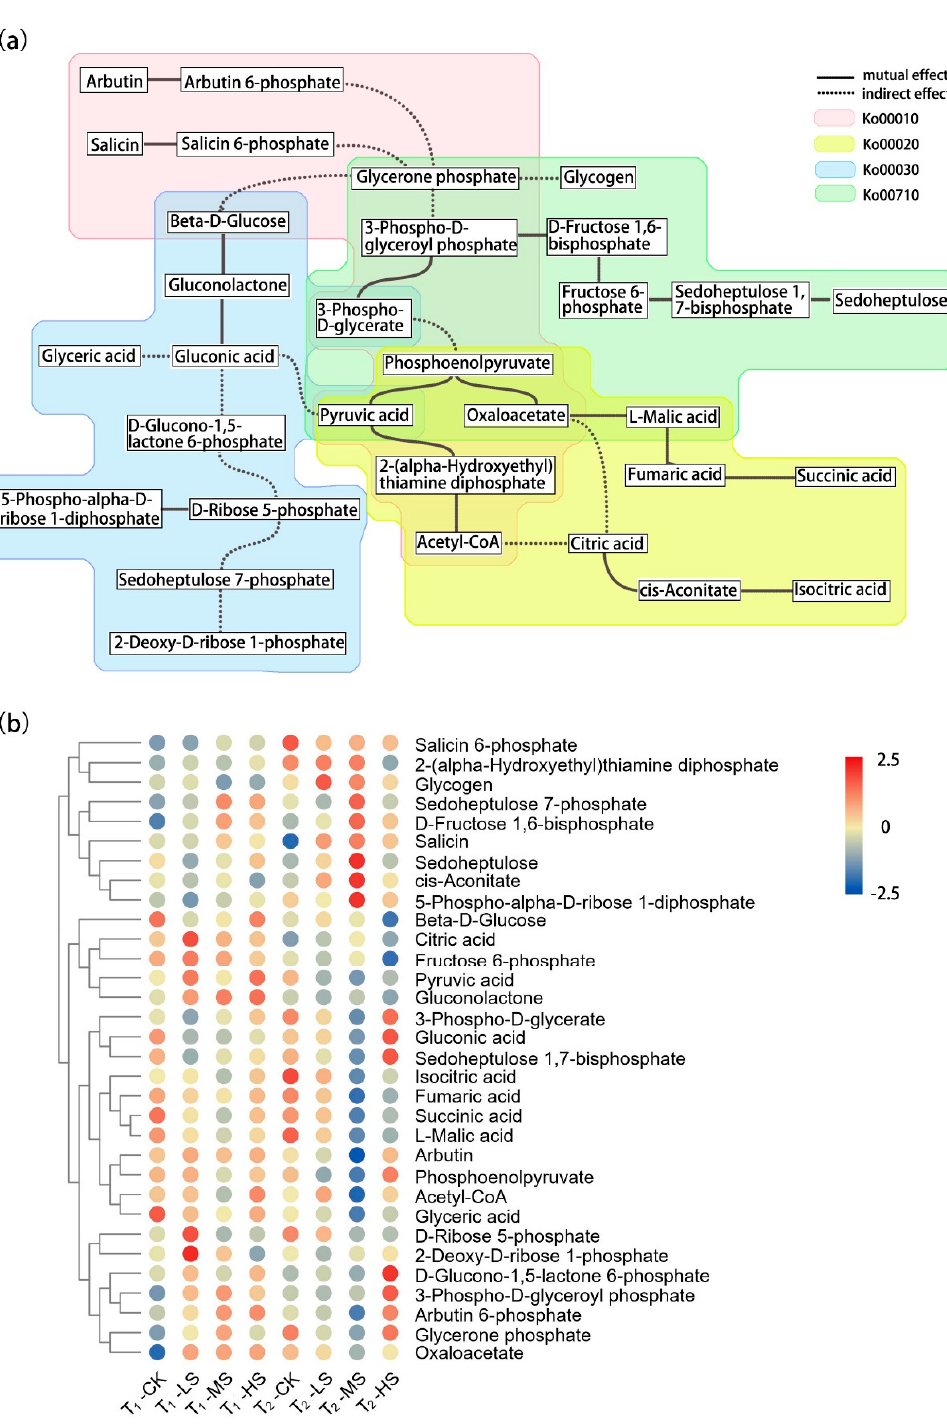
Figure 2. Changes in metabolite levels of C. paliurus leaves under different salt treatments and two sampling times. ( a ) Schematic diagram of metabolic pathways related to central metabolic processes (ko00010, glycolysis; ko00020, citrate cycle; ko00030, pentose phosphate pathway; ko00710, carbon fixation in photosynthetic organisms), and ( b ) hierarchical clustering heatmap of metabolites abundance (circle colors from red to blue represent metabolites abundance from high to low) (see Figure 1 for sampling time and treatments code).